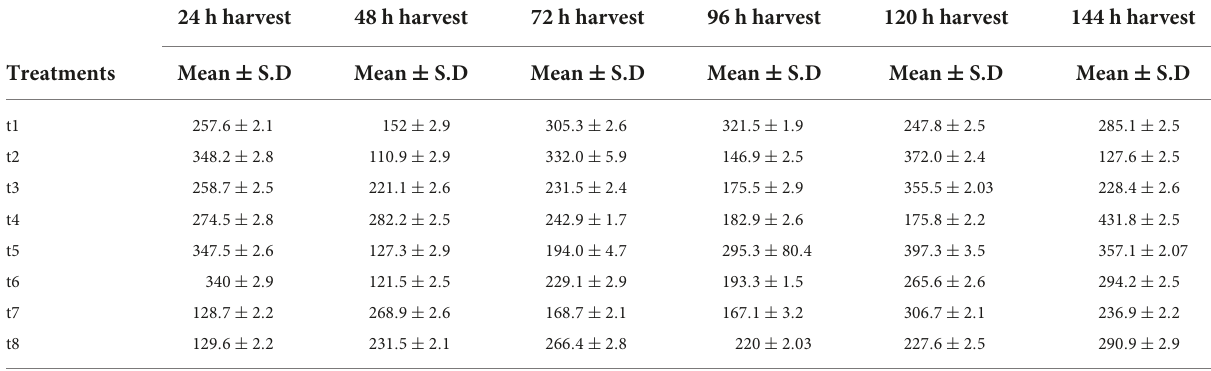
TABLE 5 Total phenolic content ( µ g g − 1 ) of Silybum marianum exposed to different treatments of elicitors.